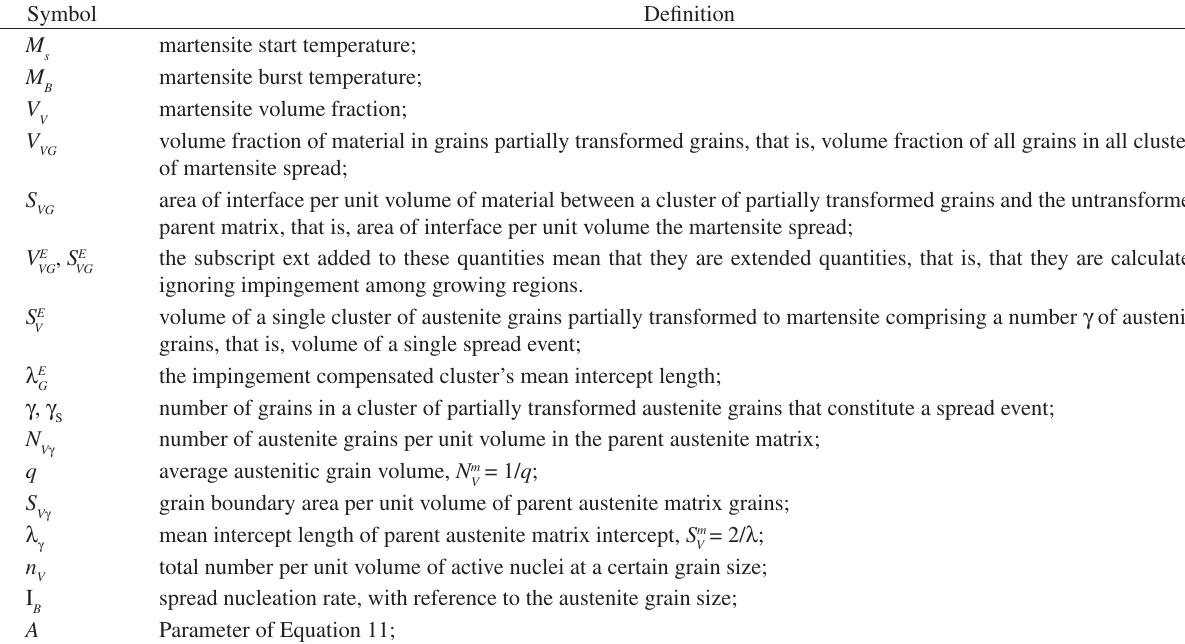
Table 3. List of symbols used in this paper and their definitions.